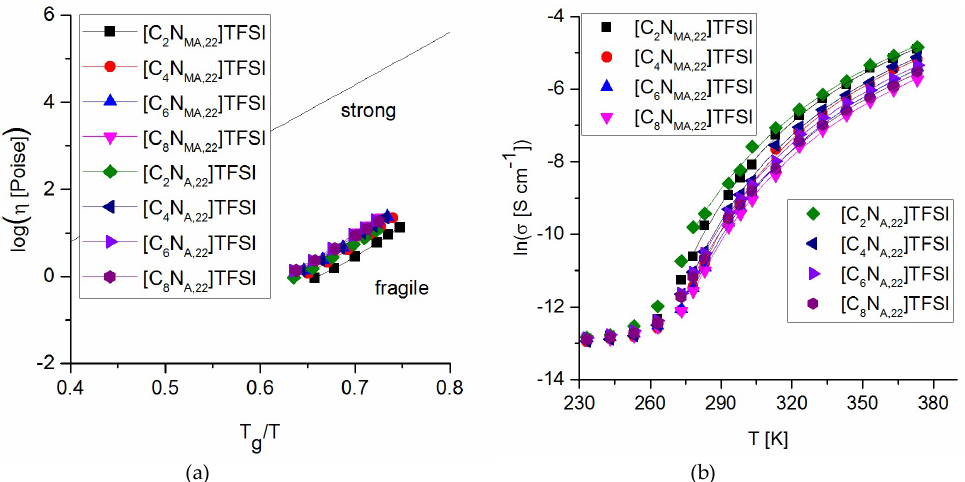
Figure 7. (a ) Arrhenius plot of fragilities; ( b ) VFT fit of ionic conductivity values.